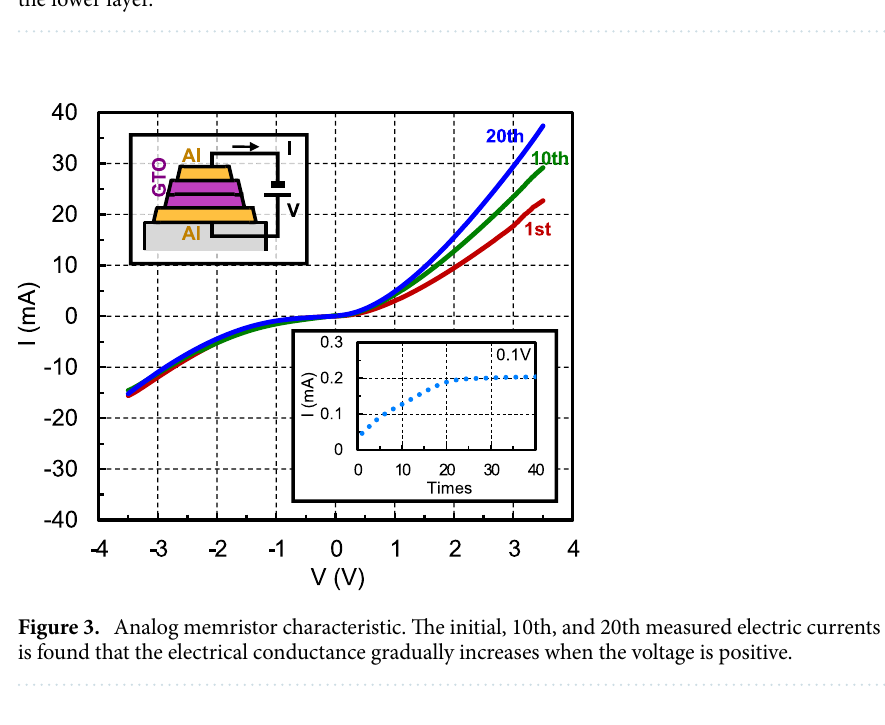
Table 1. Element analysis. It is found that the oxygen concentration in the upper layer is higher than that in the lower layer.